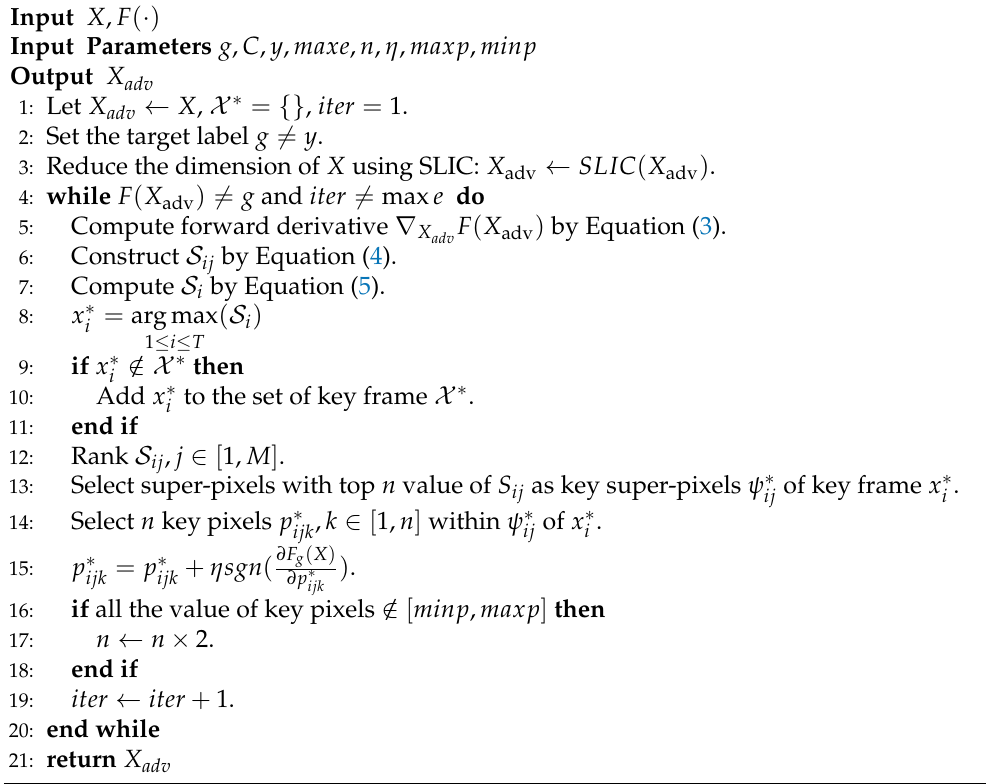
Algorithm 1 Crafting the White-Box Attack in the Target